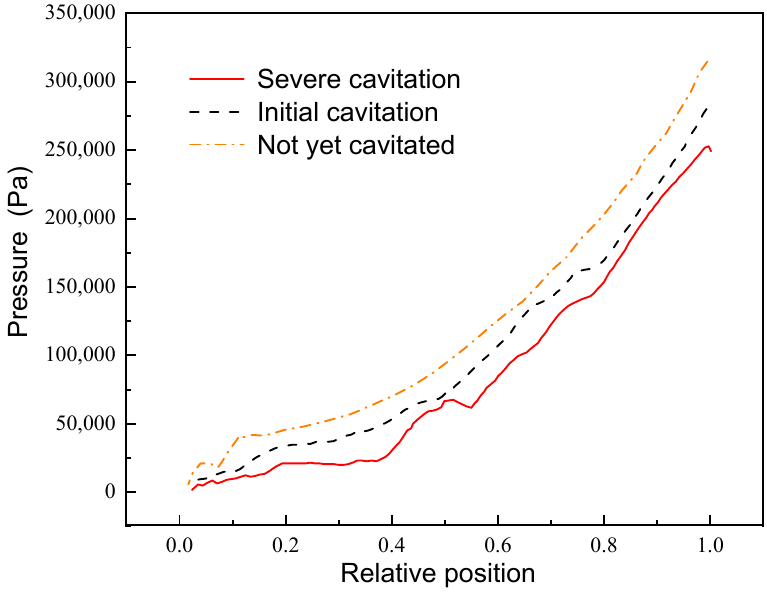
Figure 12. Blade’s suction-surface load–distribution curve.